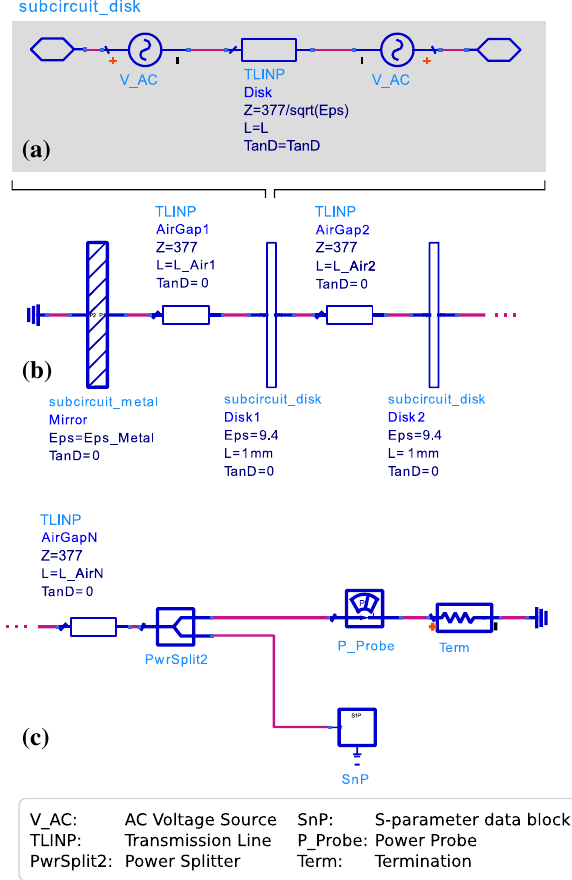
Fig. 2 One-dimensional (1D) model representation in Advanced Design System (ADS) [41]. ‘Z’ is the impedance in (cid:9) , ‘Eps’ is the dielectric constant, ‘L’ is the length, and ‘TanD’ is the loss tangent of the respective element. a Model of a dielectric disk (‘subcircuit_disk’). The discontinuity of the axion-induced field on the disk surfaces is implemented with voltage sources (‘V_AC’). The copper mirror (‘sub- circuit_metal’) is modeled analogous. b Booster model combining many dielectric disks. The mirror sub-circuit is analogous to the disk. c Antenna model. For simplicity we use a power splitter diverting some of the power received by the antenna to the S -parameter data block (‘SnP’) where the measured antenna reflectivity can be included in the model. For details cf. Sect. 4.2